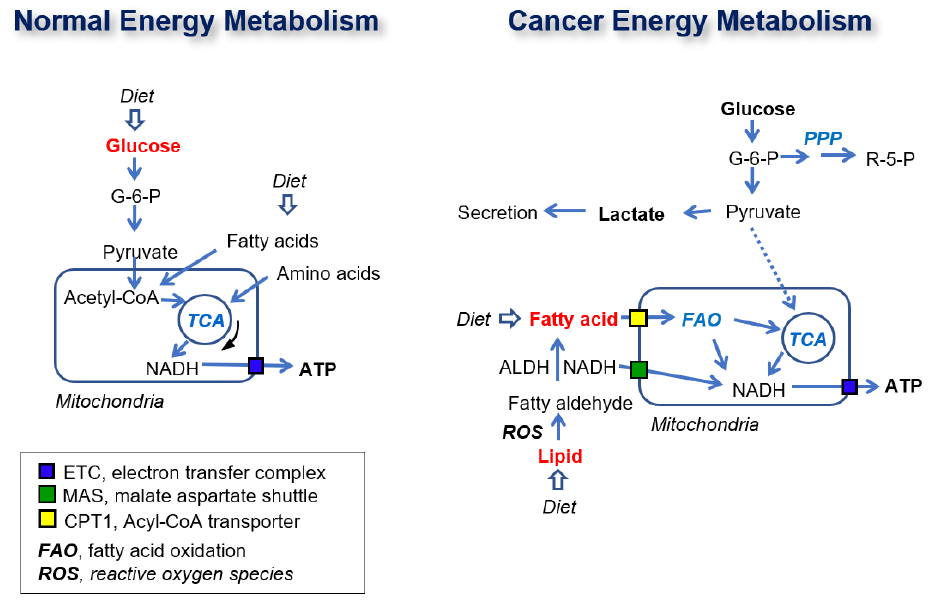
Figure 8. Schematic diagram of normal and cancer energy metabolism. The dotted line presents weak connection. The red color metabolites present major contributor of ATP production.